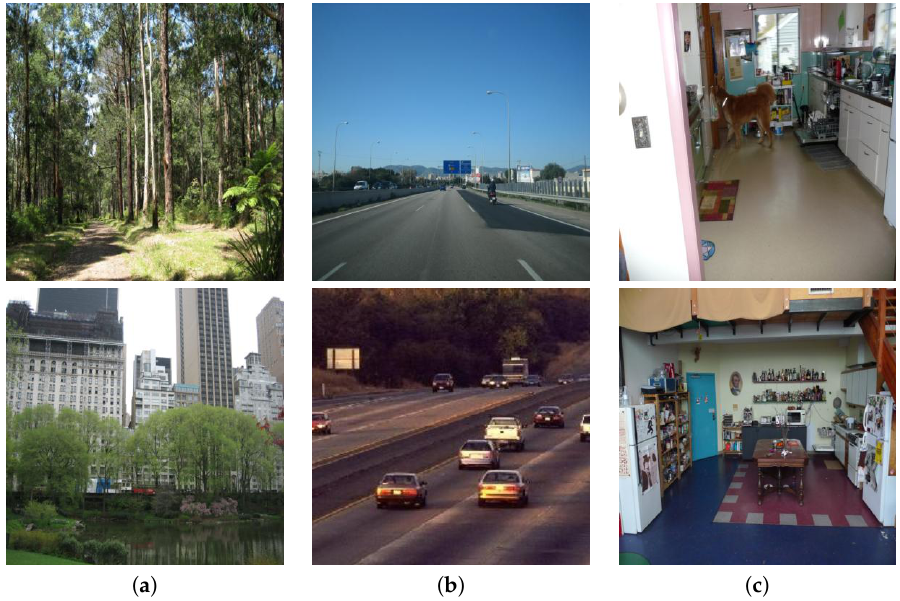
Figure 4. Example images from Broden, concepts: ( a ) Tree, ( b ) highway and ( c )